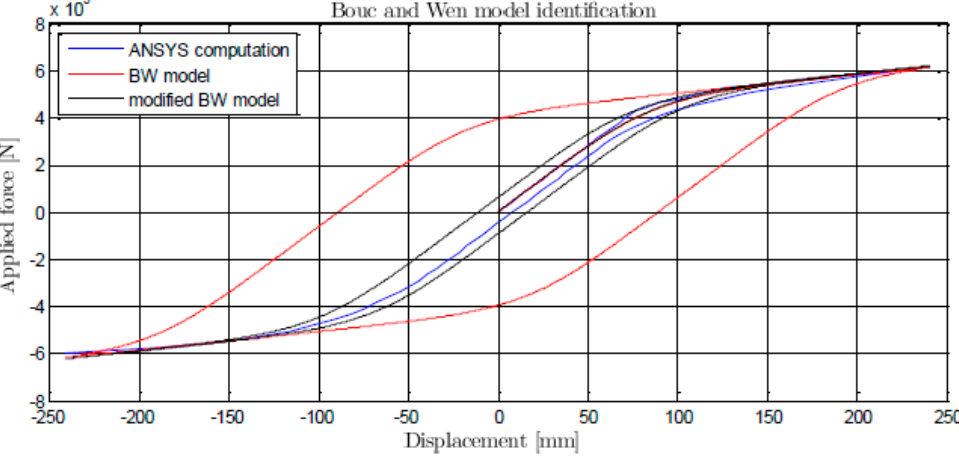
Figure 7: Comparison of the identified BW model with the ANSYS results.